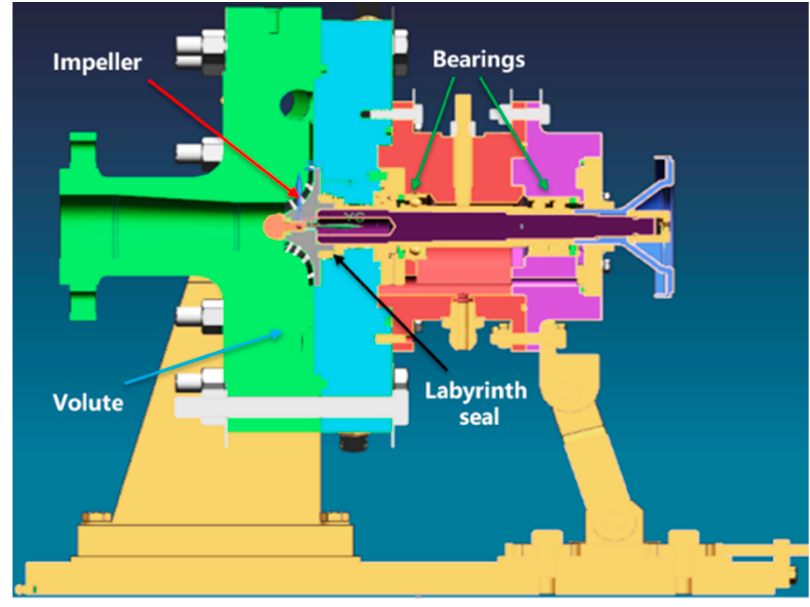
Figure 4. Schematic layout of the single-stage compressor.